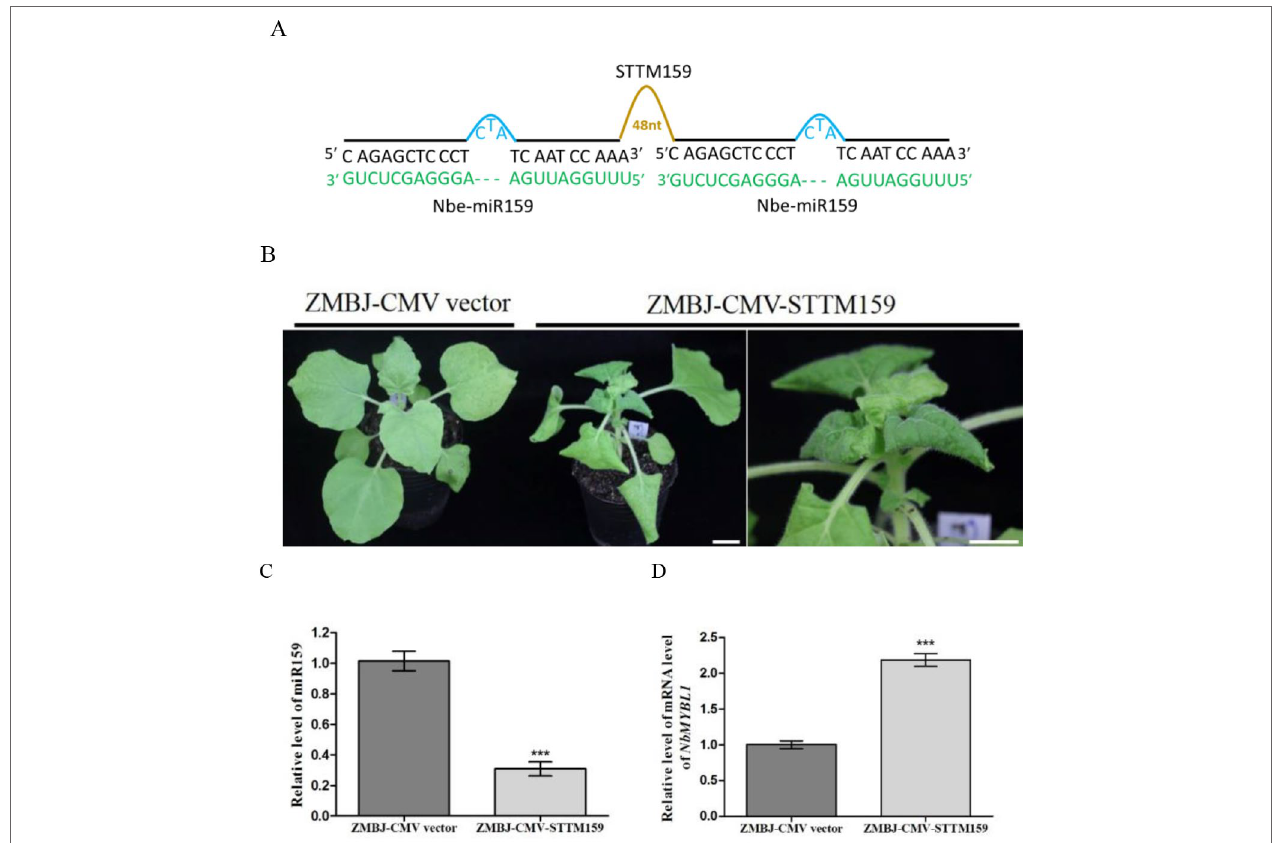
FIGURE 3 | Silencing miR159 expression in N. benthamiana using ZMBJ-CMV-STTM159. (A) A diagram of the STTM159 insert in the ZMBJ-CMV-based VbMS vector. 48 nt, a 48-nt long stem-loop like linker; —, no nt at this position. (B) Phenotypes of N. benthamiana plants infected with ZMBJ-CMV (control) or ZMBJ- CMV-STTM159. Photographs were taken at 14 dpi. An enlarged image of the ZMBJ-CMV-STTM159 infected plant is shown at the right side. Bars = 2 cm. (C) Relative expression of miR159 in N. benthamiana determined by the stem-loop RT-qPCR. (D) Relative expression of miR159 target NbMYBL1 in the ZMBJ- CMV (control) or ZMBJ-CMV-STTM159-infected plants. The 2 nd upmost young leaves were harvested from the assayed plants at 14 dpi and used for this study. The results were analyzed and presented as described in Figure 2 . ***, p <